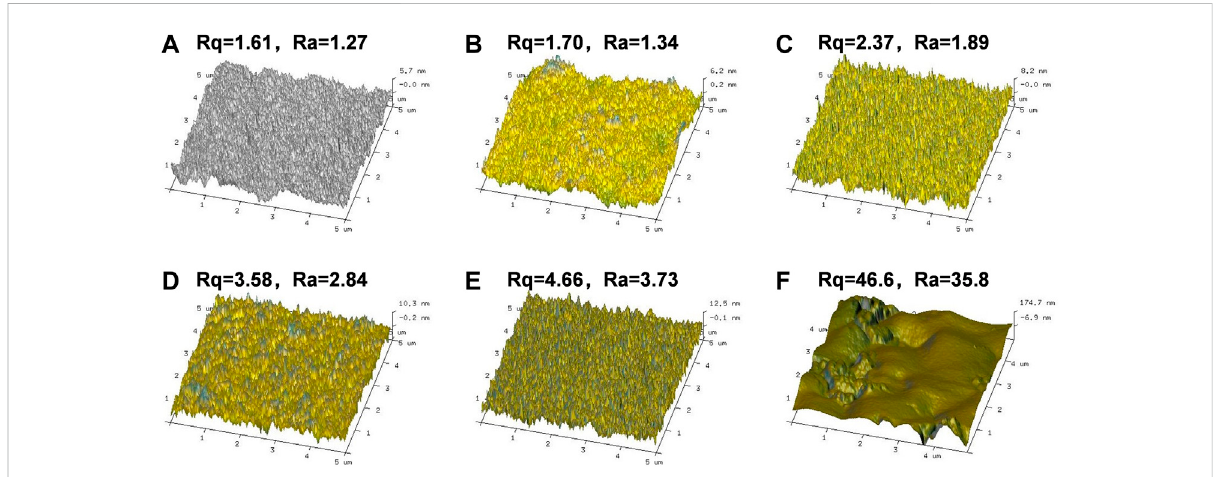
FIGURE 4 Atomic Force Microscope (AFM) ofPVAand PVA/BL fi lms. (A) PVA; (B) PVA-0.5%BL; (C) PVA-1.0%BL; (D) PVA-3.0%BL; (E) PVA-5.0%BL; (F) PVA-